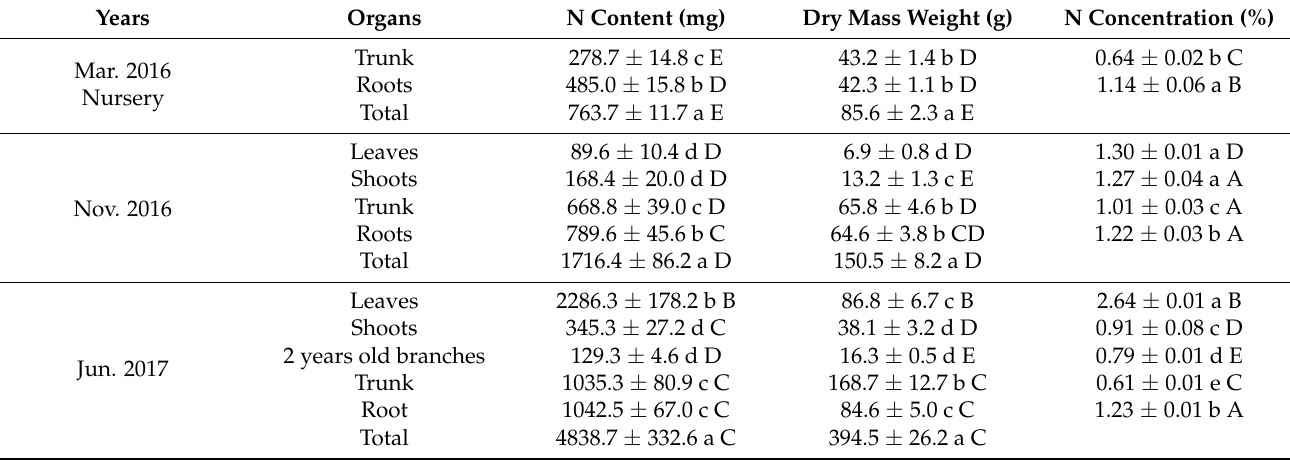
Table 3. The dry mass weight, N content and concentration of each pear tree